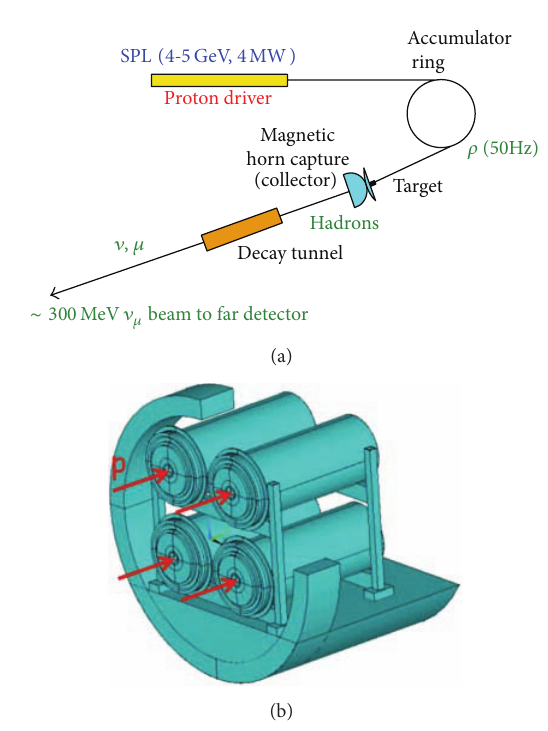
Figure 18: (a) Layout of the CERN to Fr´ejus Super Beam. (b) Conceptual engineering design of the 4 target and horn system for the Super